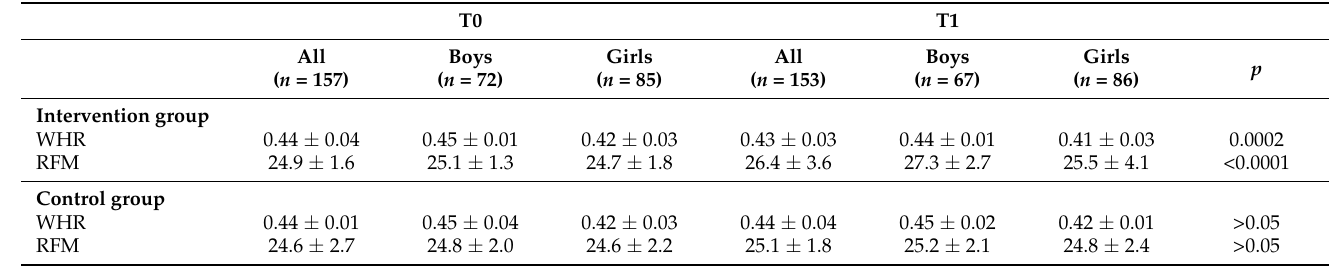
Table 3. WHR and RFM measurements at T0 and T1.